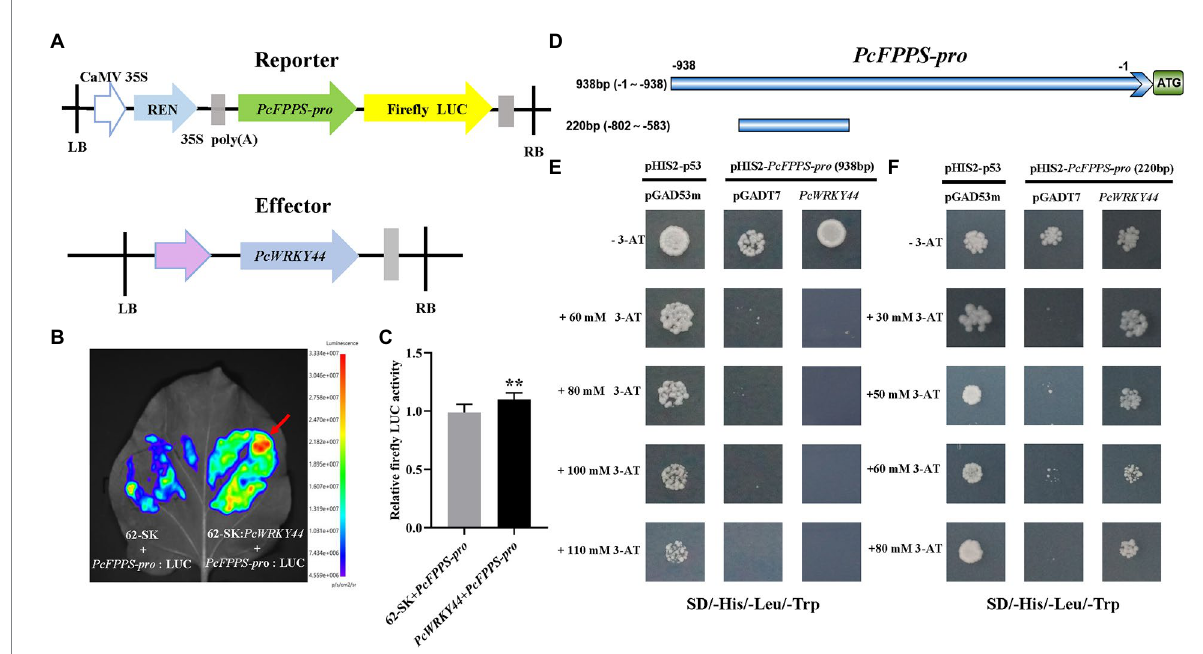
FIGURE 6 Dual-luciferase experiment and Yeast one-hybrid assay confirm that PcWRKY44 could bind to the PcFPPS-pro in vivo and vitro . (A) Schematic diagrams of the construction of reporter vector and effector vector. (B) Dual-LUC reporter imaging assay. N. benthamiana leaves were injected with the Agrobacterial GV3101-pSoup-p19 strains containing 62-SK + PcFPPS - pro :LUC and 62-SK: PcWRKY44 + PcFPPS - pro :LUC. Arrow position indicates the strongest fluorescence. (C) Relative firefly LUC activity assay in tobacco leaves. Error bars are shown with six biological replicates. (Student’s t -test: ** p < 0.01). (D) A schematic of PcFPPS promoter. The upper horizontal line represents the 938 bp promoter of PcFPPS , while the lower one represents 220 bp. (E) Yeast one-hybrid assays between the 938 bp PcFPPS-pro and PcWRKY44. Plasmids pHIS2-p53 and pGAD53m were cotransformed into Y187 as the positive control. (F) Yeast one-hybrid assays between the 220 bp PcFPPS-pro and PcWRKY44. Positive colonies indicated strong specific interactions between the 220 bp PcFPPS-pro and